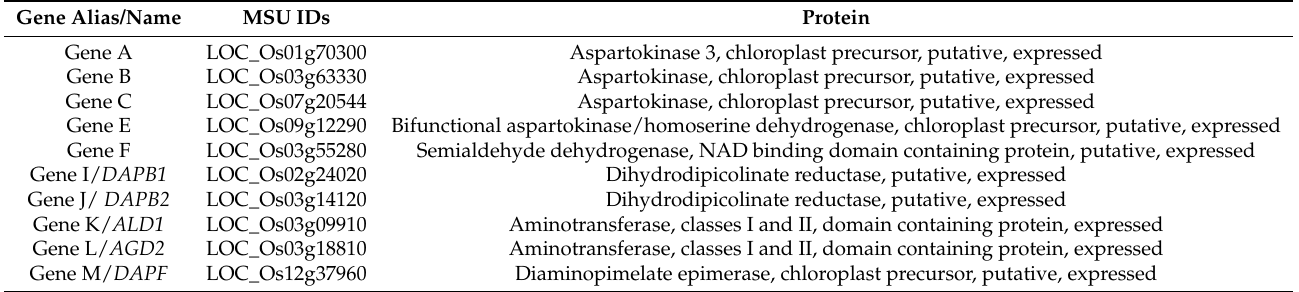
Table 3. Protein encoded by intervention genes in Figure 8 and Tables 1 and